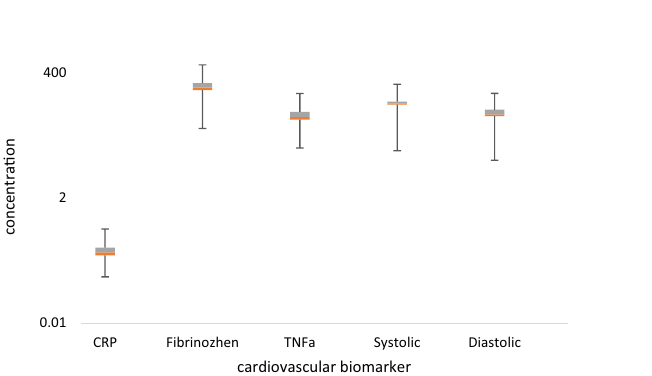
Figure 2. The concentration of heavy metals on PM 10 . ( a ) Normal day and ( b ) Dust storm.